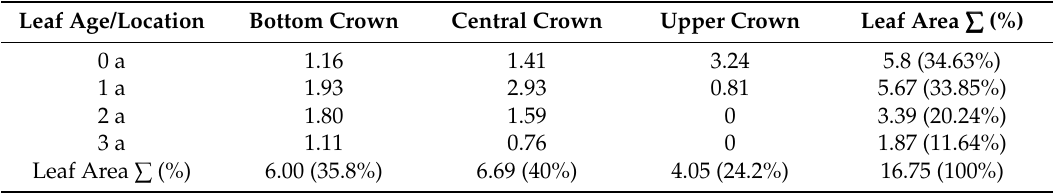
Table A1. Leaf area and proportion of leaves at different ages located at different crown positions for Cunninghamia trees in Hunan.